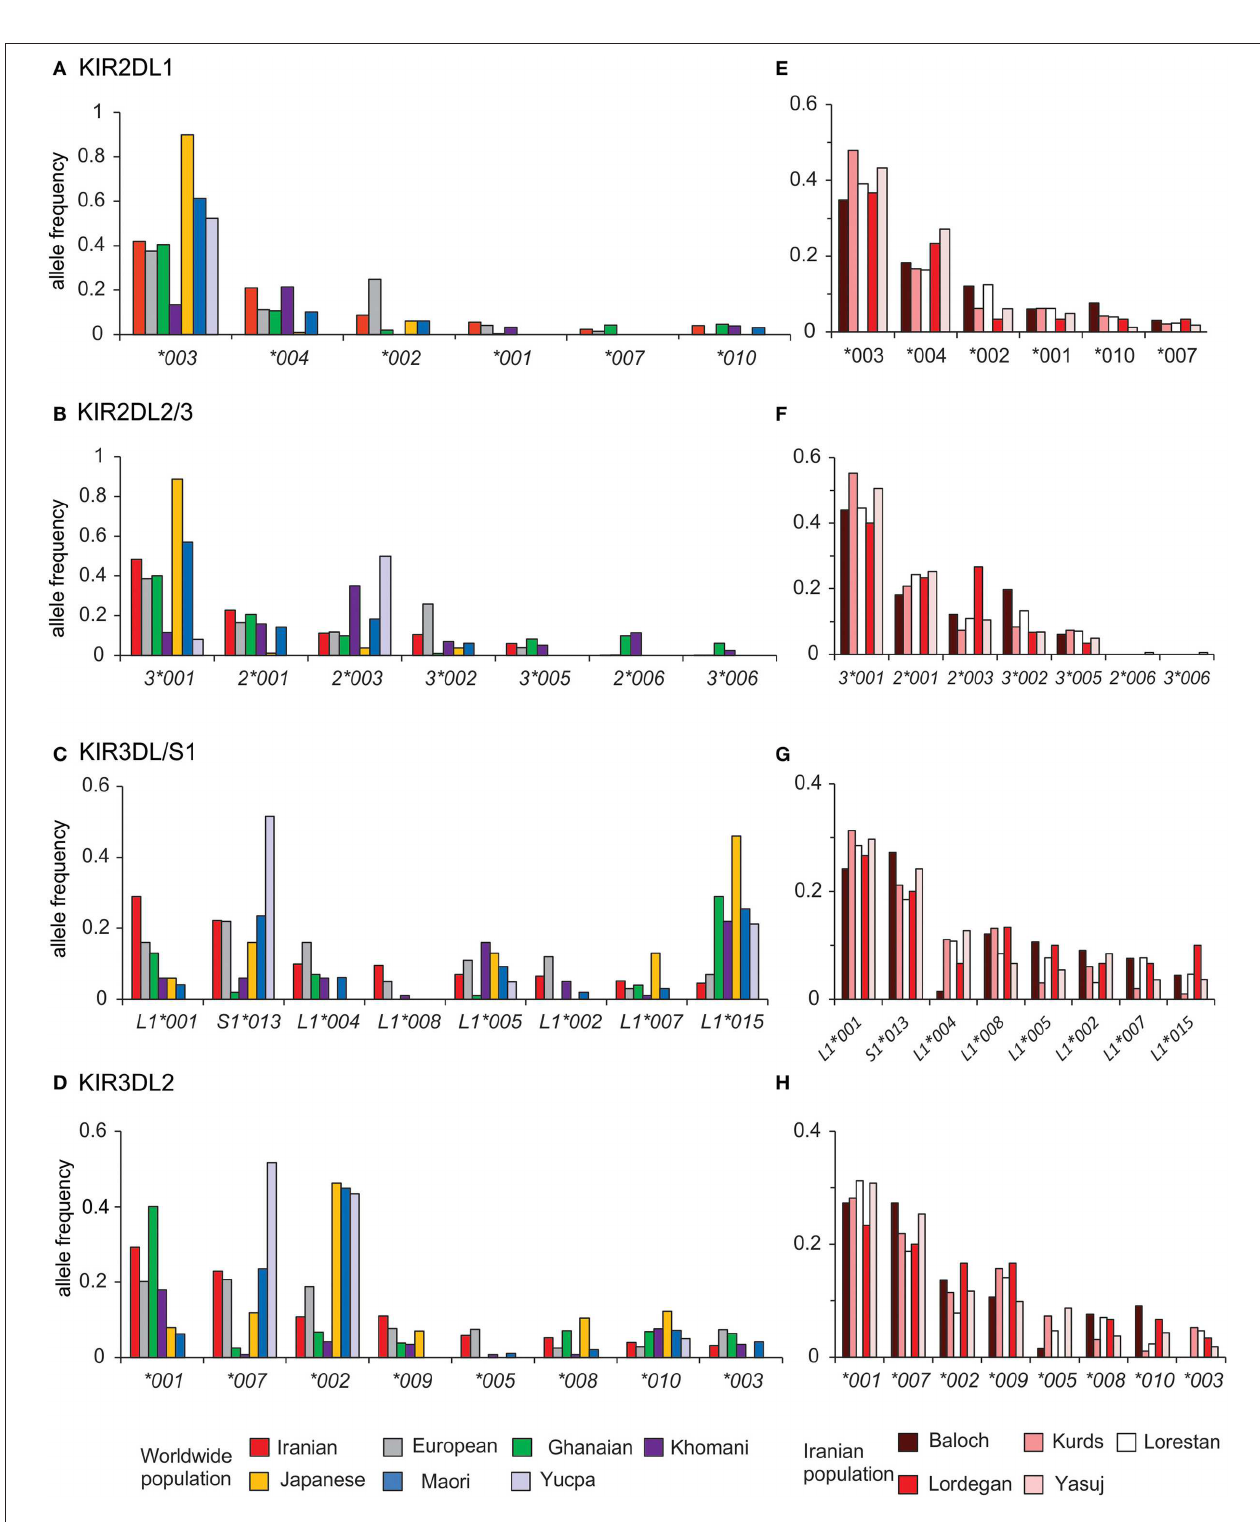
FIGURE 5 | Telomeric KIR are more divergent than centromeric KIR across populations. Shows the alleles of (A) KIR2DL1 , (B) KIR2DL2 /3, (C) KIR3DL1/S1 , and (D) KIR3DL2 observed in Iran, and their frequencies in the combined Iranian population and six other populations representing major world groups (Left). (E-H) show the allele frequencies in the individual Iranian populations. The populations are Iranians ( N = 241, comprised from Baloch N = 33, Kurds N = 48, Lorestan N = 64, Lordegan N = 15, and Yasuj N = 81), Ghanaians ( N = 131), Khomani ( N = 79), Maori ( N = 49), Japanese ( N = 115), Europeans ( N = 378), and Yucpa ( N = 61). The allele frequencies for all KIR genes in each of the five Iranian populations are given in Supplementary Material .